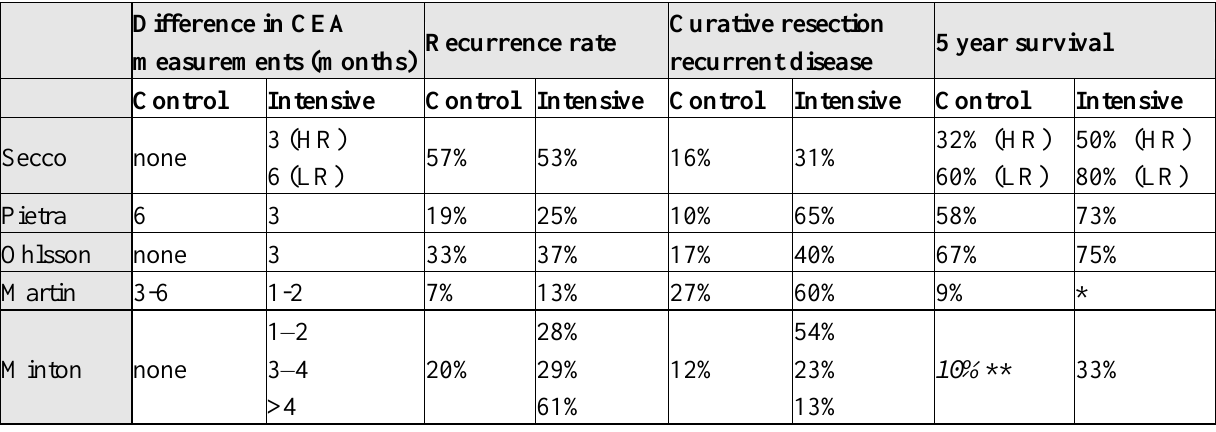
Table 2. Effect of CEA measurements in FU on resectability of recurrent disease and 5 year survival.